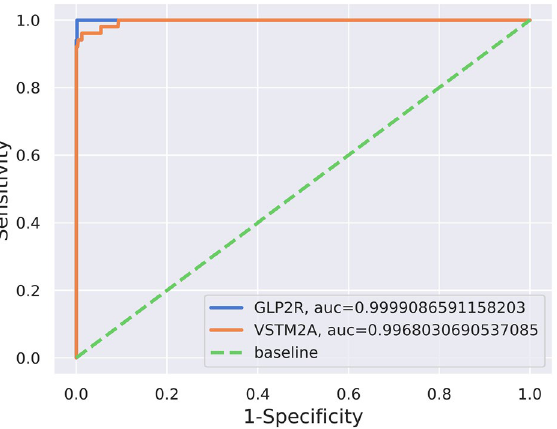
Figure 9. ROC curve for the finalized features GLP2R and VSTM2A in classifying the tumor and normal classes of CRC dataset. The blue color denotes the AUC for GLP2R gene, red color denotes the VSTM2A gene, and the green color is baseline for the sample classification.